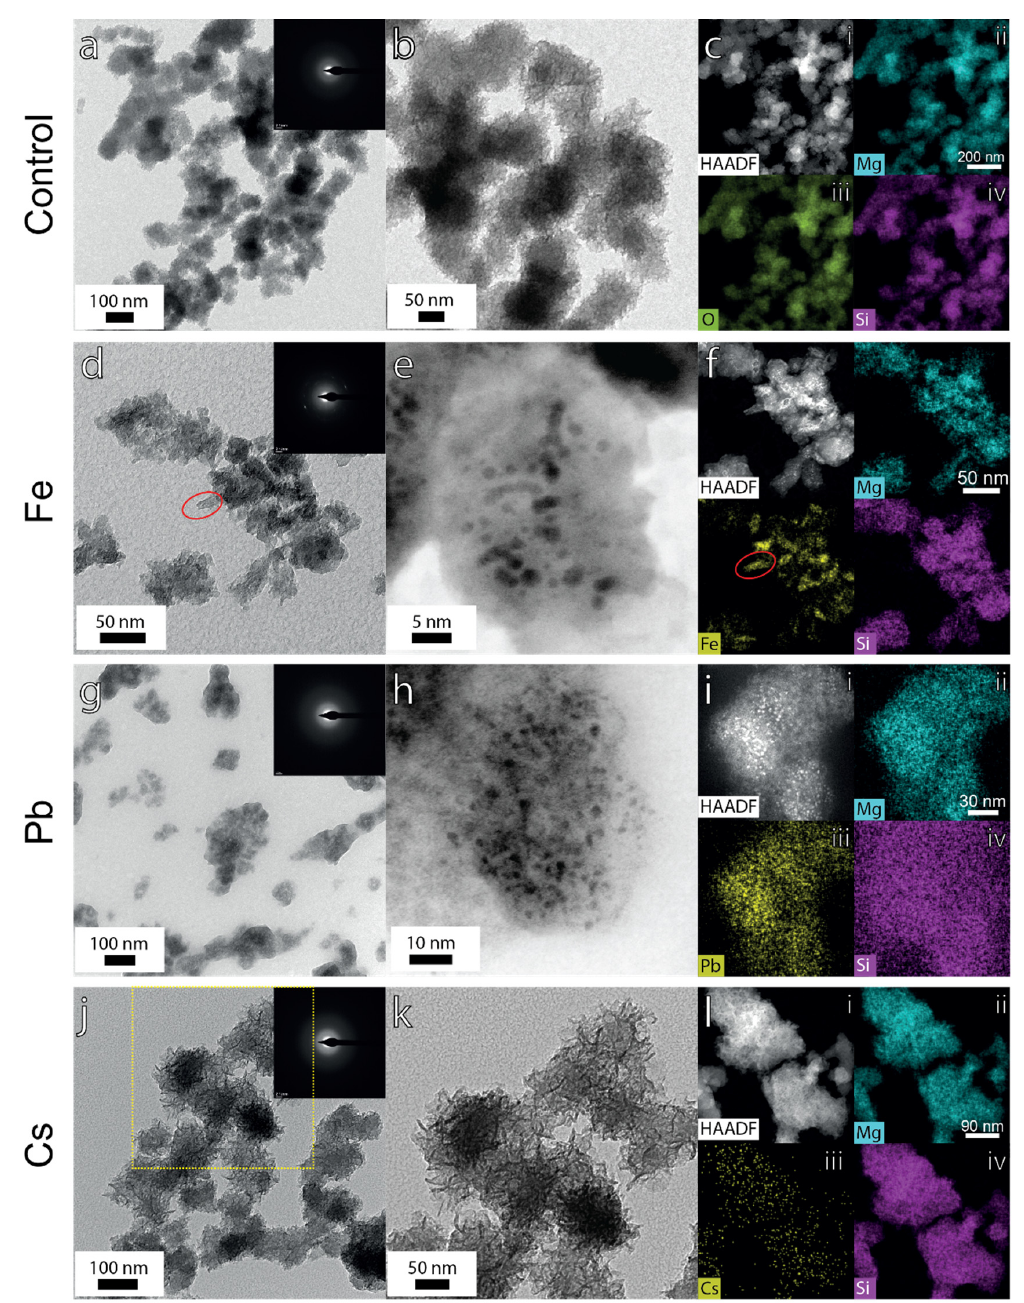
Figure 5. Transmission electron microscopy (TEM) images of precipitated crystals ( a , b ) pure M-S-H system with selected area electron diffraction (SAED) pattern inset; ( c ( i – iv )) elemental mapping of the pure M-S-H; ( d , e ) Fe-containing M-S-H samples SAED pattern inset; ( f ( i – iv )) elemental mapping of Fe-containing M-S-H, red ellipse highlight Fe-rich regions within the M-S-H matrix; ( g , h ) Pb-containing M-S-H samples SAED pattern inset; ( i ( i – iv )) elemental mapping of Pb-containing M-S-H; ( j ) Cs-containing M-S-H samples SAED pattern inset; ( k ) zoom into the yellow square in ( j ); ( l ( i – iv )) elemental mapping of Cs-containing M-S-H.